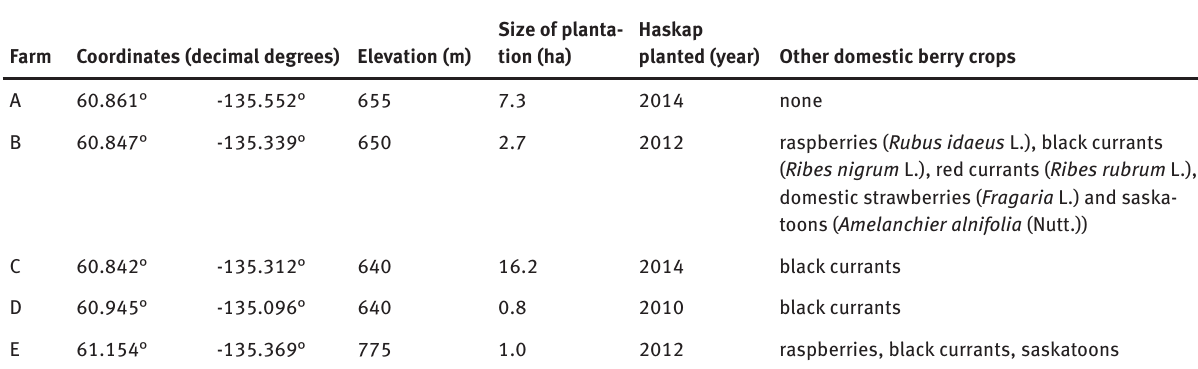
Table 1: Characteristics of each study site. “Size of plantation” refers to entire plantation area; haskap made up only a portion of this area in each farm (see Methods), with the remainder not planted or devoted to other crops.